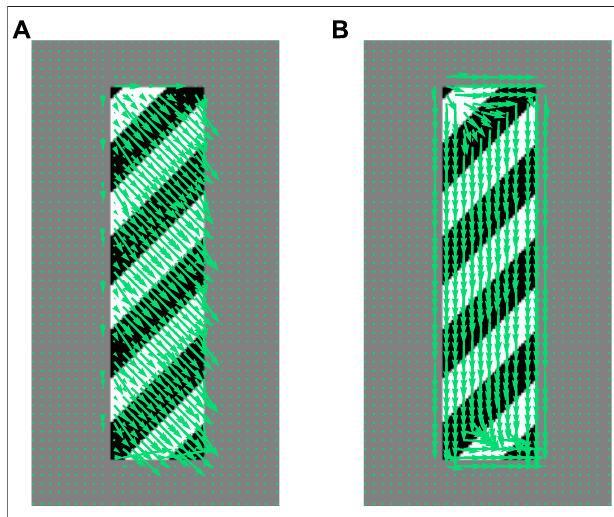
FIGURE 3 | Barber ’ s pole optical fl ow (sub-sampled). (A) Horn – Schunck method (Horn and Schunck, 1981) with smoothing